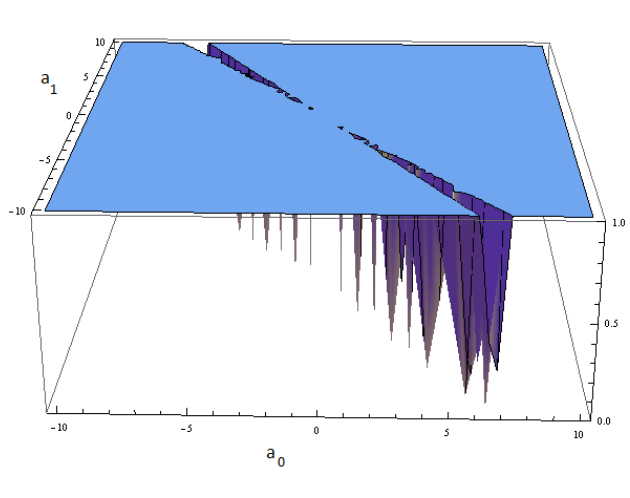
Figure 1. Stability region of z = 1.